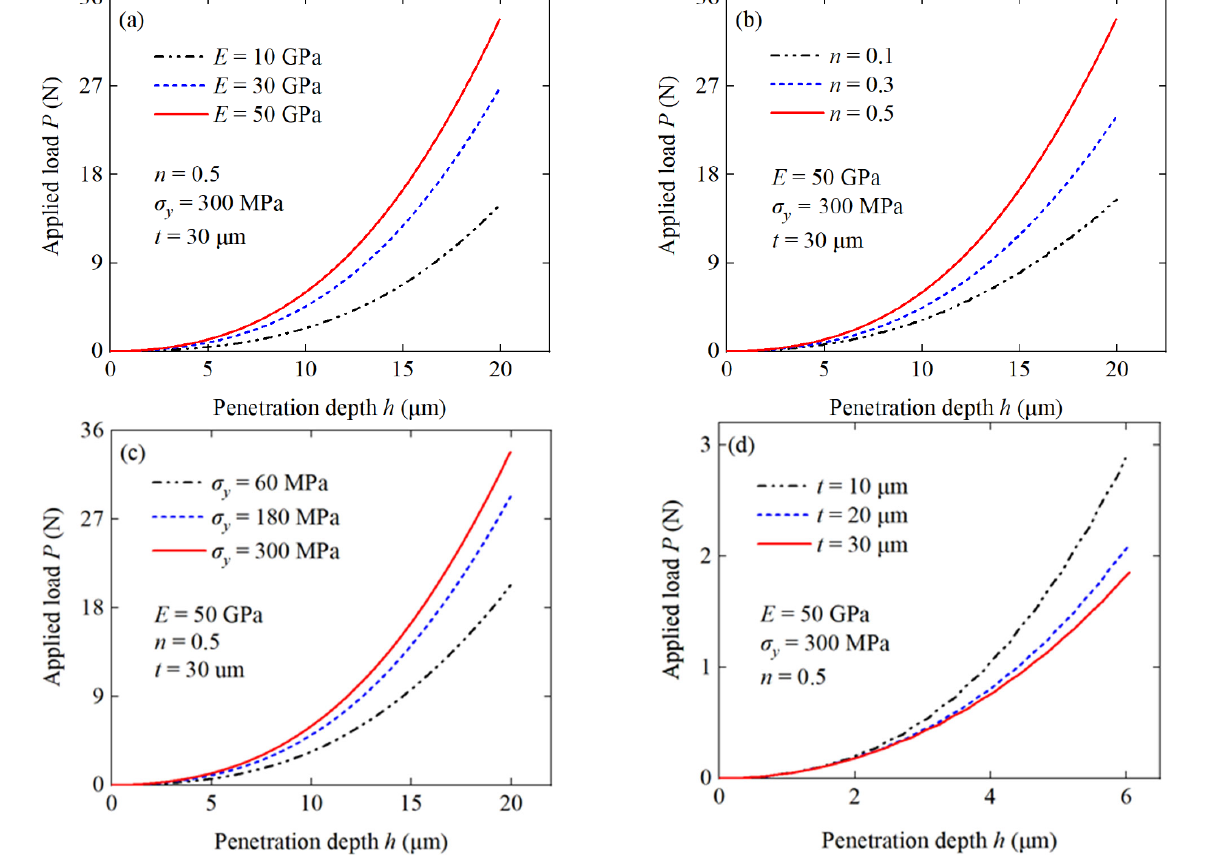
Figure 11. Effect of material parameters and film thickness on the P ‐ h responses: ( a ) Young’s mod ‐ ulus; ( b ) hardening exponent; ( c ) yield strength; ( d ) film thickness. ( b ) hardening exponent; ( c ) yield strength; ( d ) film thickness.